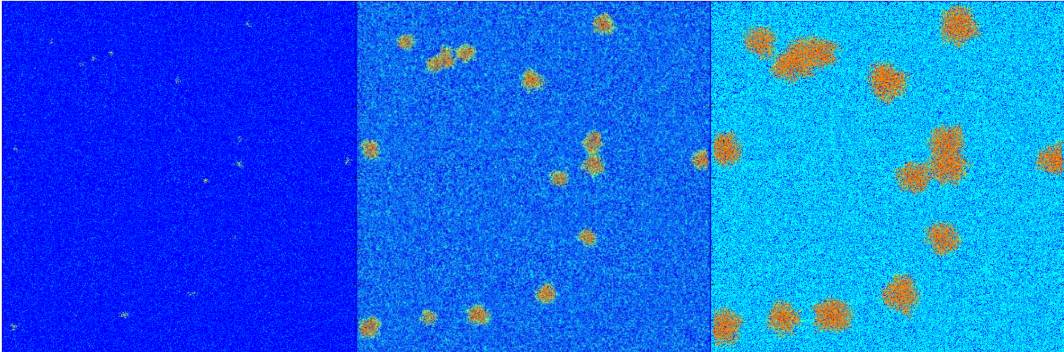
Figure 2. An example to present the epidemic spatial evolution (time ( t ) = 20, 60, and 120